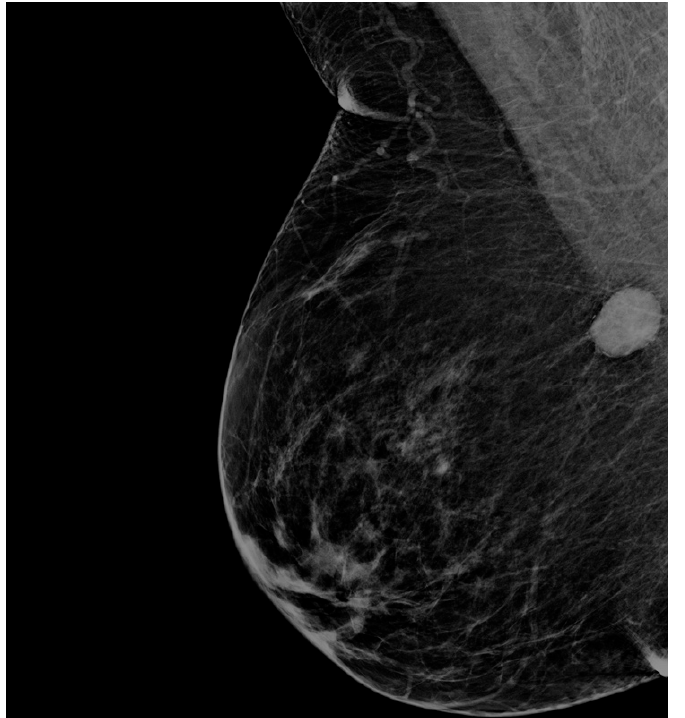
Figure 1. Right breast mammogram—mediolateral oblique incidence.